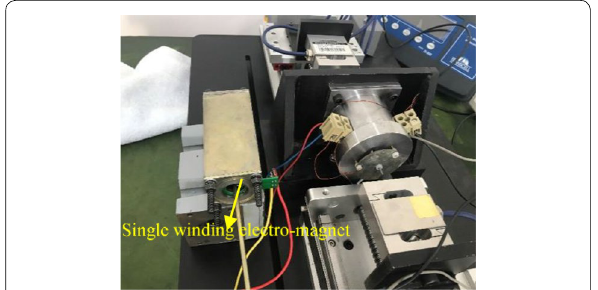
Figure 22 Single winding electromagnet